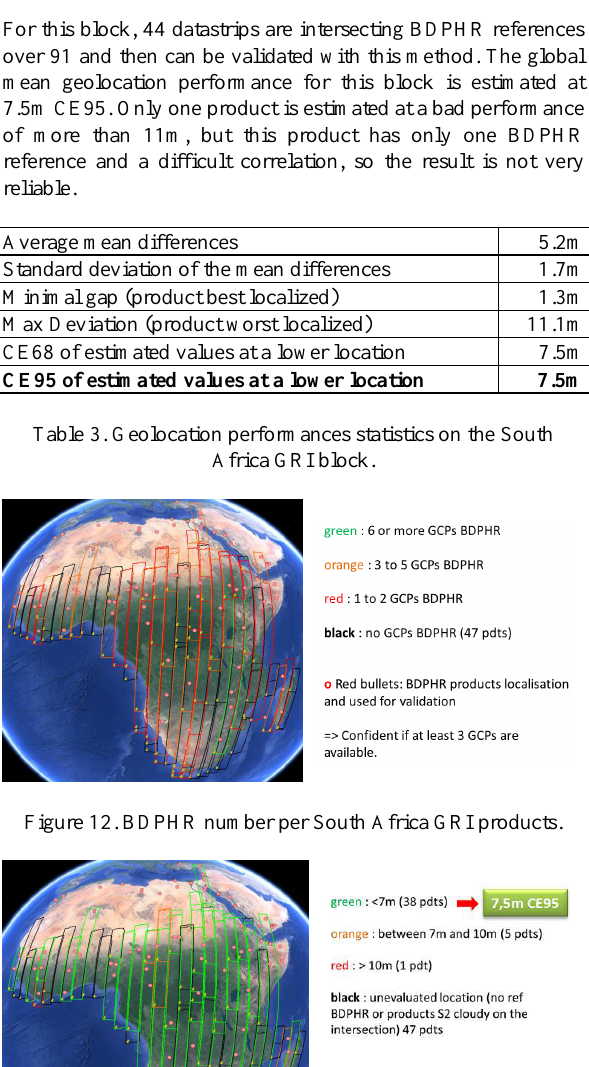
Figure 8. BDPHR number per Australian GRI products.